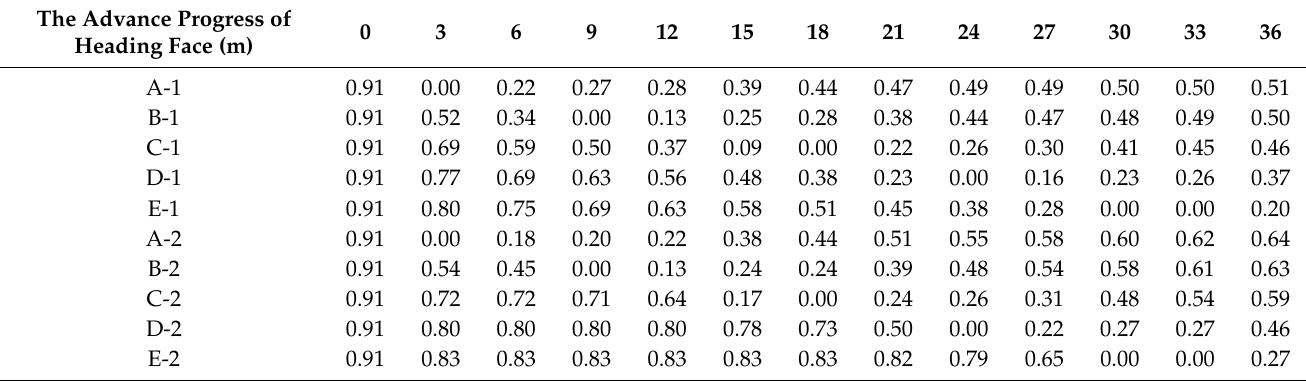
Table 6. Variation diagram of pore water pressure outside the grouting range (Unit: MPa).